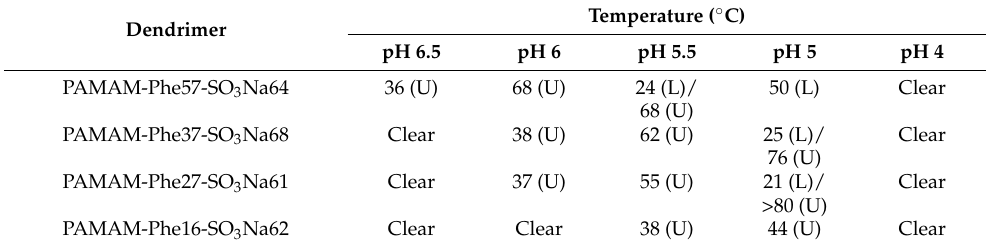
Table 3. pH-switchable thermosensitive behavior of PAMAM-Phe-SO 3 Na at different pH values 1